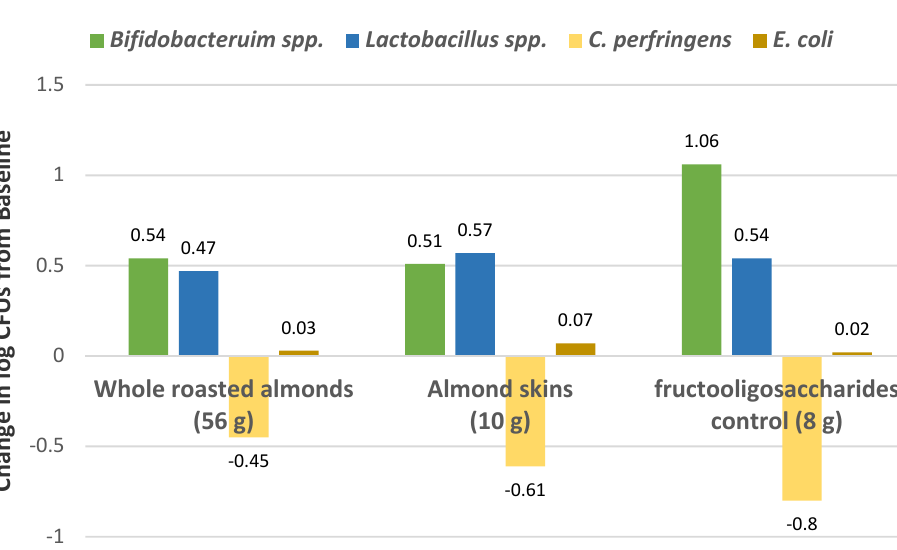
Figure 39. Change in colony-forming units (CFUs) from baseline to 6 weeks: (1) symbiotic bacteria Bifidobacterium and Lactobacillus increased ( p ≤ 0.05 for all) and (2) pathogenic bacteria Clostridium perfringens decreased for fructooligosaccharides and almond skins ( p < 0.05) and whole almonds ( p < 0.1), and there were no significant changes in fecal E. coli ( p > 0.05) [97].